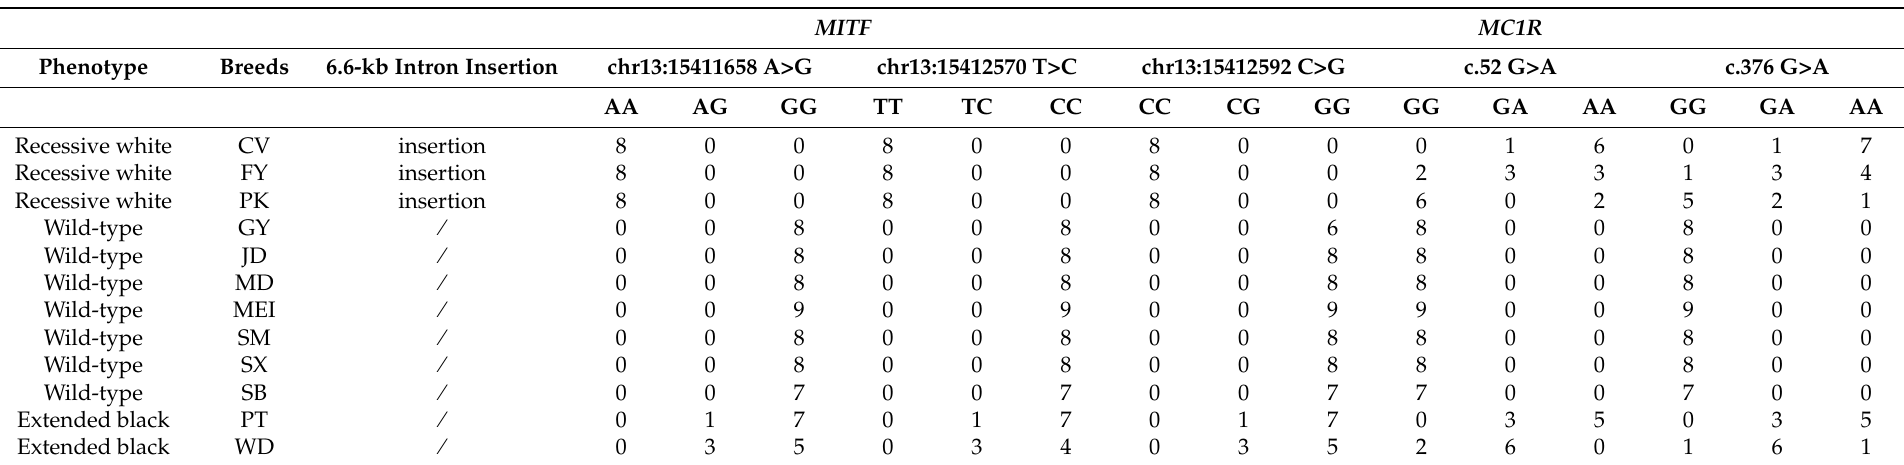
Table 2. Genetic polymorphisms in MC1R and MITF